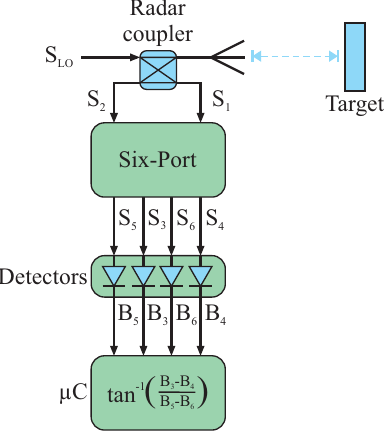
Figure 8. Six-port system for interferometric distance